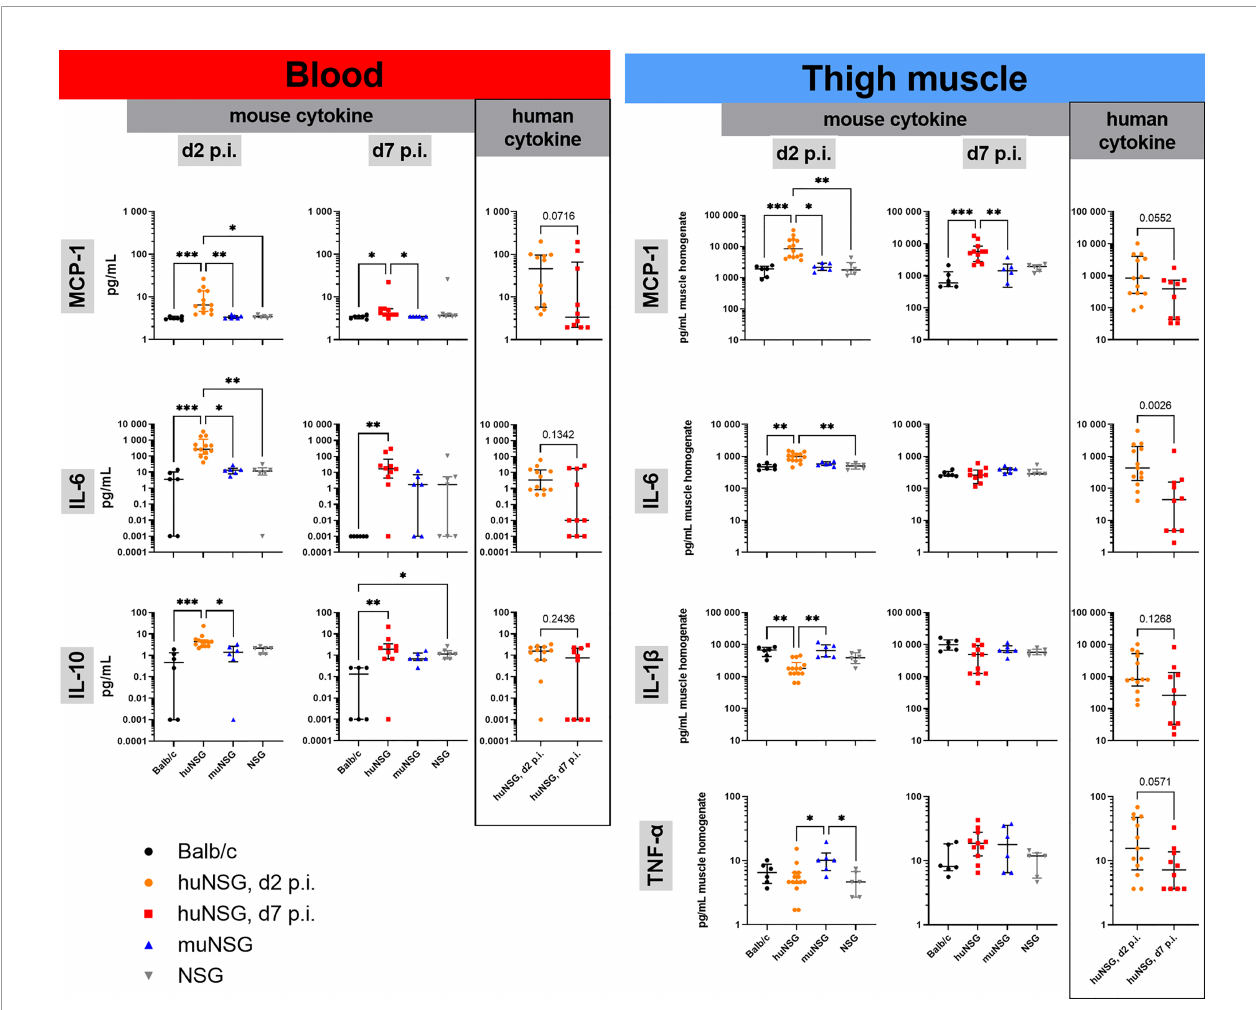
FIGURE 4 | Cytokine levels in blood and infected thigh muscle at early and late time point of infection. Displayed are the individual levels per mouse and the median with interquartile range for each respective group/time point. Levels in blood serum or muscle homogenate were determined with customized Luminex panels. Statistical signi fi cance was tested by Kruskal-Wallis with Dunn ’ s post-test for the murine cytokines or Mann-Whitney-test for the human counterparts (*p ≤ 0.05, **p ≤ 0.01, ***p ≤